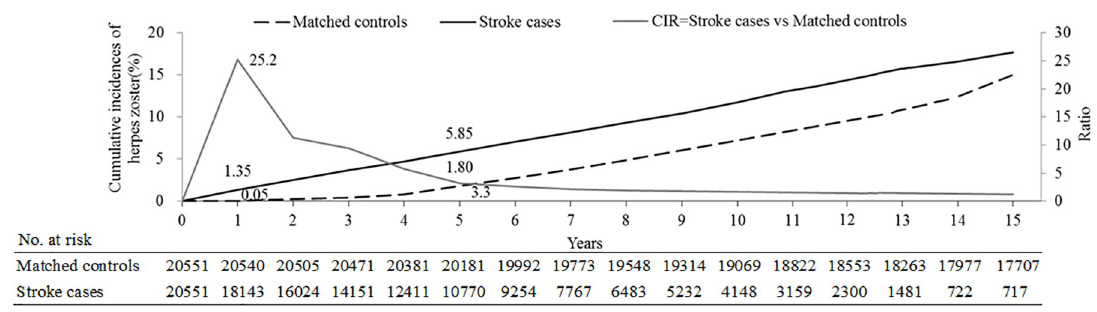
Fig 2. Cumulative incidences of herpes zoster.